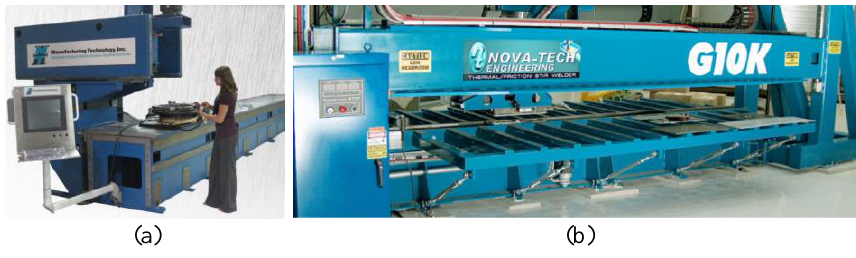
Fig. 4. Panel welding machines from MTI (USA) (a) and Novatech (USA)